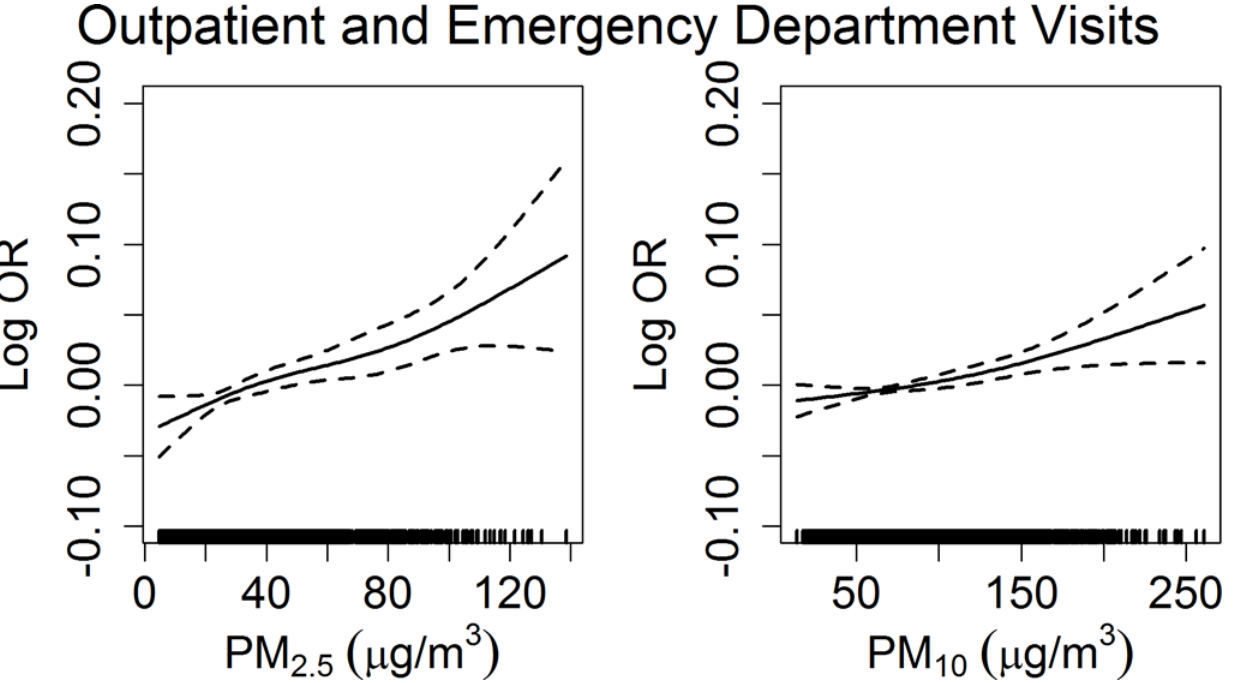
Fig 1. Smoothing plots of PM 2.5 (left) and PM 10 (right) against CHD outpatient and emergency department visits. X-axis is the PM concentrations at lag 01. The solid lines indicate the estimated mean percentage of change in daily outpatient and emergency department visits for CHD, and the dotted lines represent twice the standard